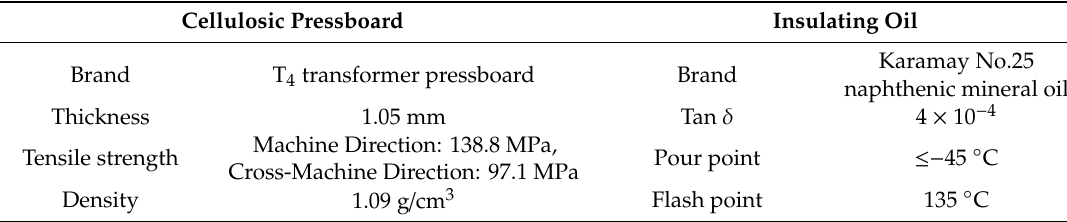
Table 1. Details of used cellulosic pressboard and insulating